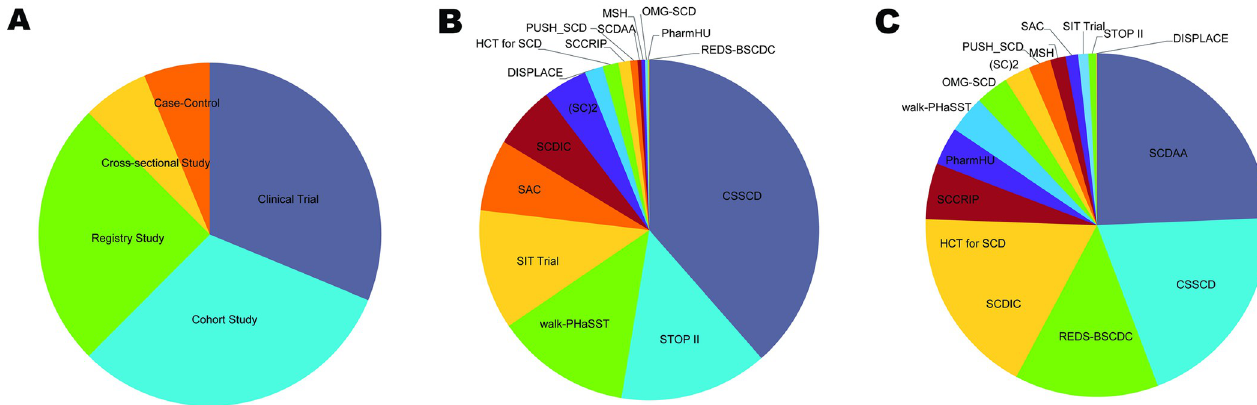
Fig 1. Distribution of 16 curated studies in the Metadata Catalog by experimental design, collected variables, and patient size, available on the CureSCi MDC homepage. A. Proportion of curated studies by study design. B. Distribution of study variables ( > 10,000) across the curated studies. C. Distribution of subjects ( > 20,000) among the curated studies. Republished from https://curesicklecell.rti.org/ under a CC BY license, with permission from Public Library of Science (PLOS), original copyright 2022.